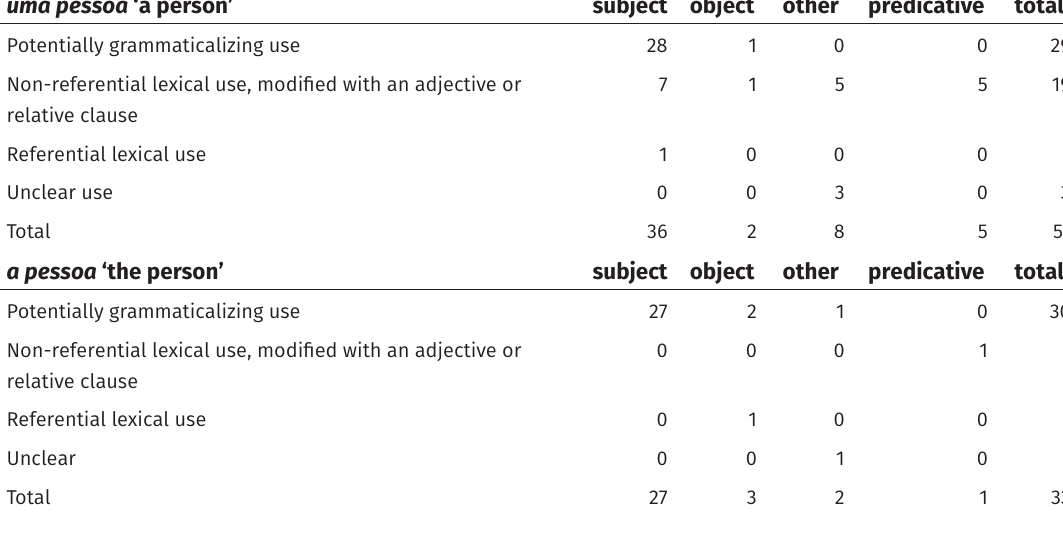
Table 1: Occurrences of uma/a pessoa in the Português Falado no Porto corpus. uma pessoa ‘a